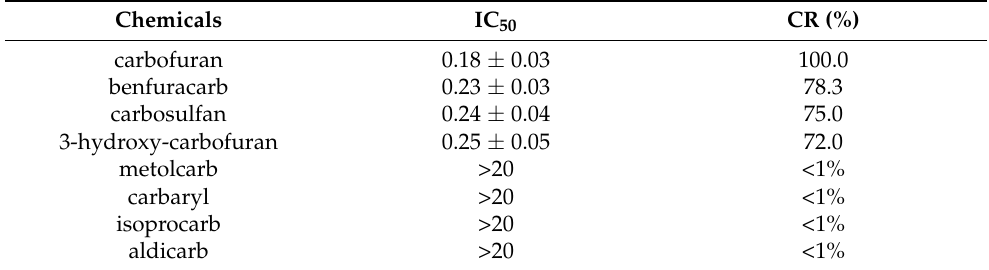
Table 3. Cross-reactivity of ELISA between carbofuran and carbofuran